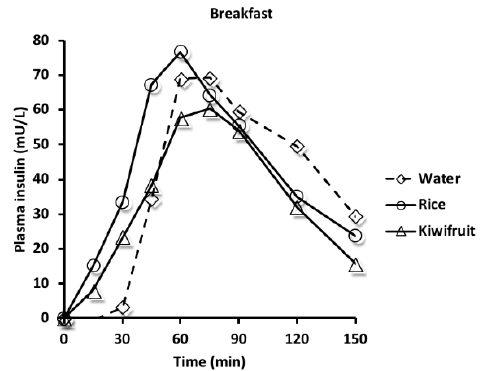
Figure 4. Mean incremental change in plasma insulin concentrations at breakfast from baseline (time 0) at which time preloads of water, rice, or kiwifruit were followed at 30 min by the remainder of the rice meal.